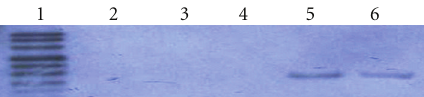
Figure 5: Detection of LMP2A expression in SGC cells by PCR- Southern blotting. Lane 1: DIG-labeled DNA molecular weight marker VIII (Roche); lane2: SGC cells; lane 3: vAd infected SGC cells; lane 4: negative control (PCR on total RNA without reverse transcription); lane 5: vAd-2A-infected SGC cells; lane 6: positive control (EBV-positive LCL).